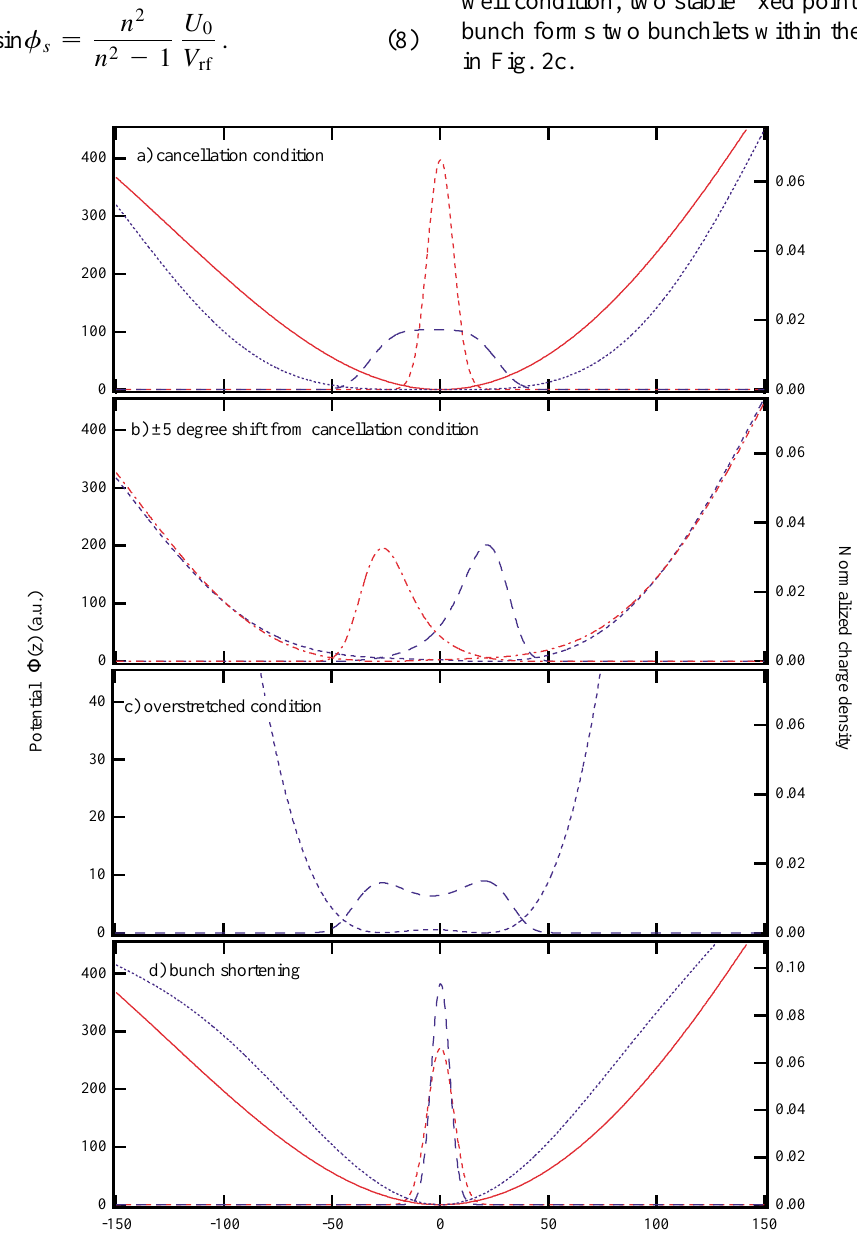
FIG. 2. (Color) Potential well and longitudinal distribution for several cases of harmonic voltage. (a) Nominal distribution and distribution for cancellation condition. (b) Cancellation condition with 5 ± phase shifts. (c) Overstretched condition with 5% larger harmonic voltage. (d) Bunch shortening with the same harmonic voltage as